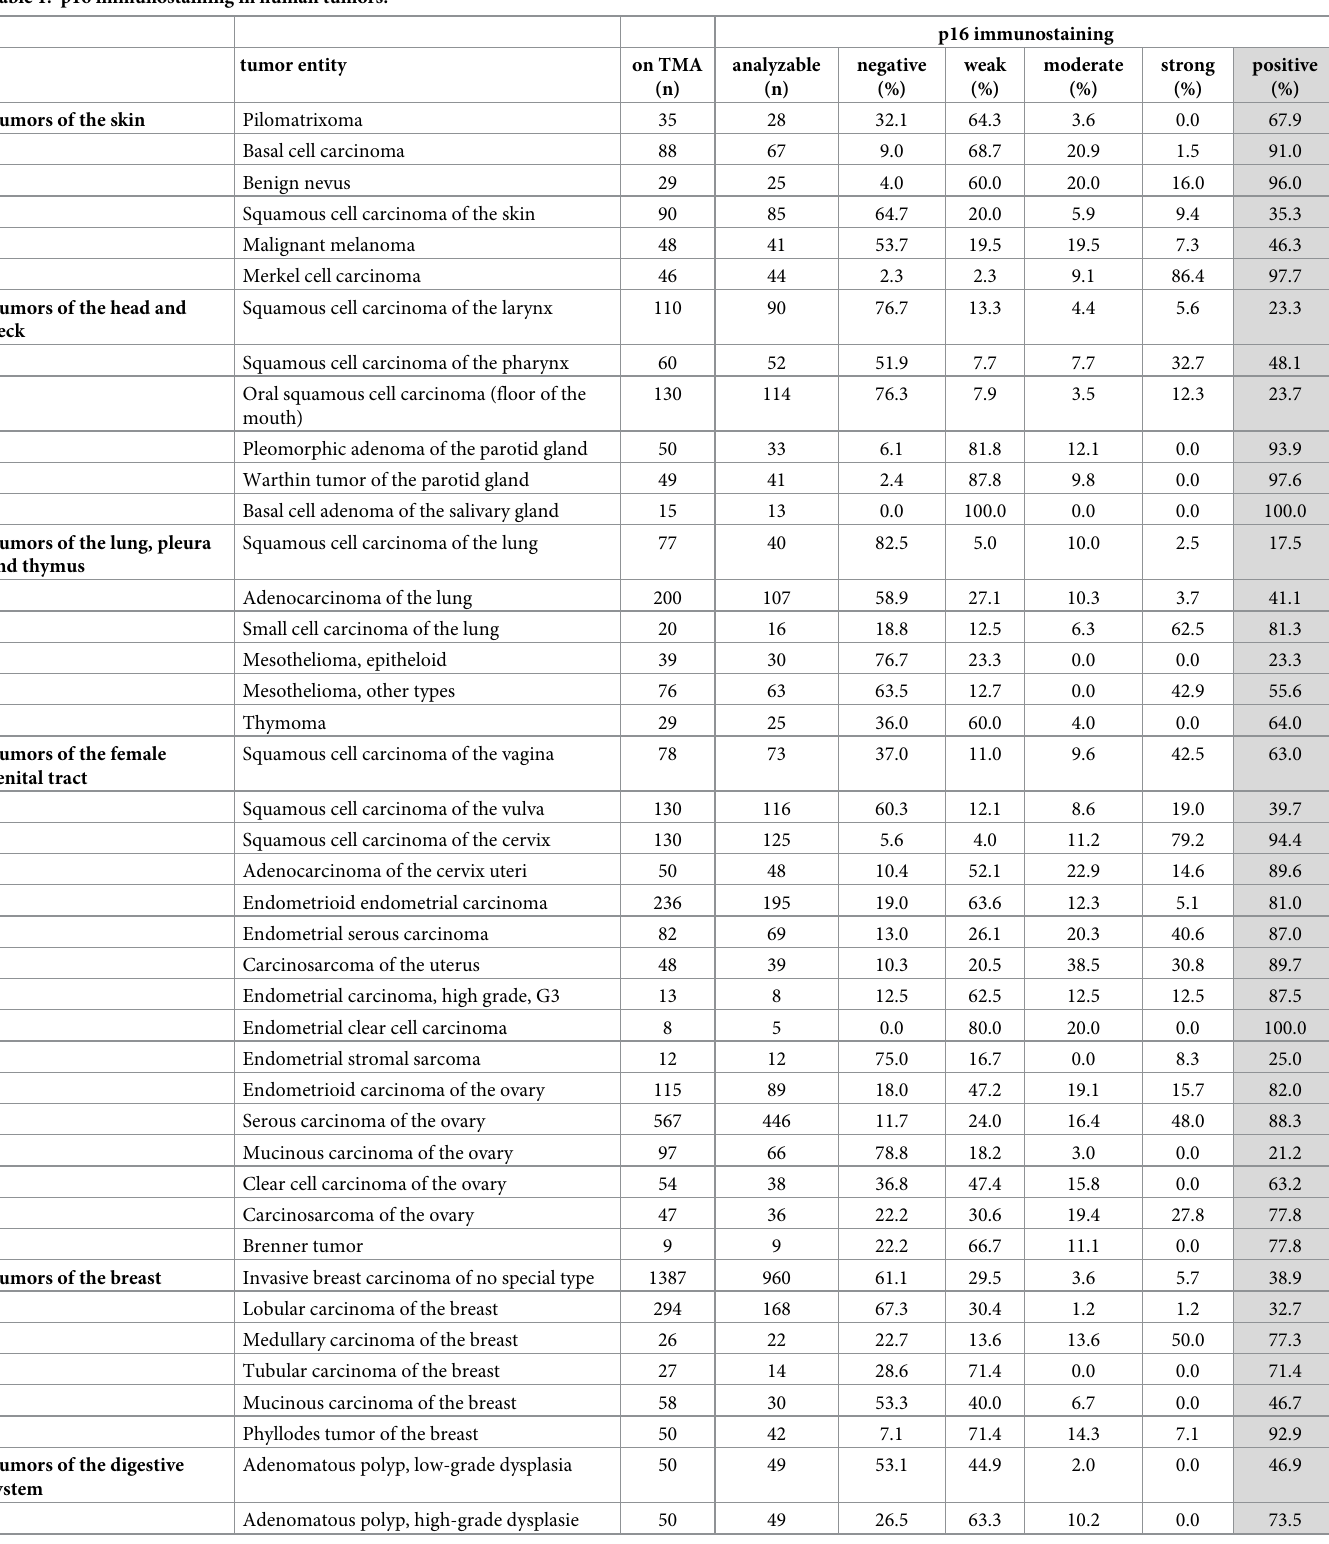
Table 1. p16 immunostaining in human